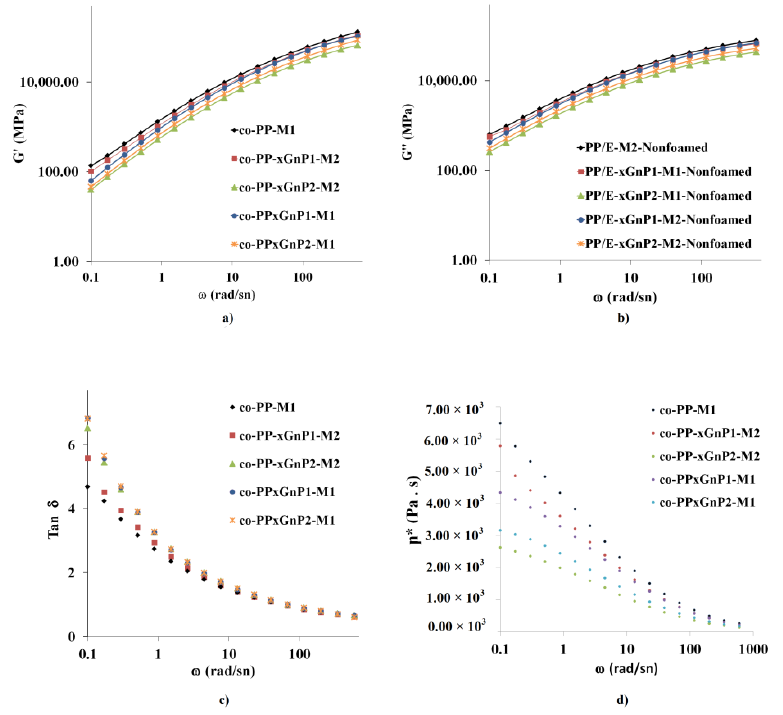
Figure 11. Rheological measurement results of ( a ) storage modulus, ( b ) loss modulus, ( c ) tan δ , and ( d ) complex viscosity of prepared samples.